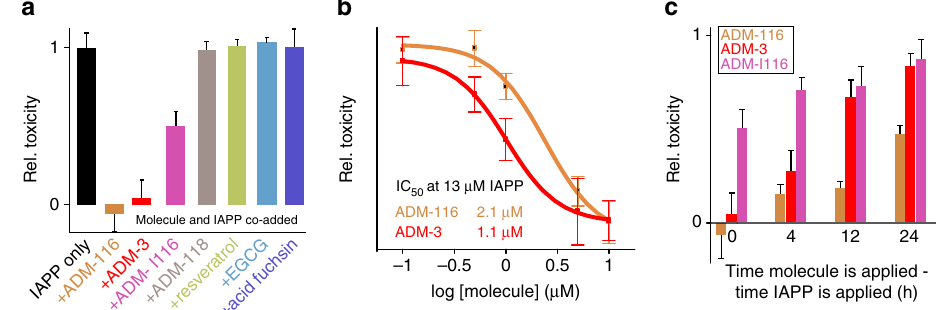
Figure 4 | Rescue of INS-1 cells from IAPP-induced toxicity. ( a ) Statistics of the toxic effect of 13 m M IAPP applied at time zero to INS-1 cells and measured 48h later using CellTiter Blue. Data are shown for IAPP alone and with equimolar ratio of the indicated small molecule co-added at a 1:1 ratio. Data are renormalized to the toxicity induced only by IAPP. Each condition is the average of eight on-plate repeats from each of three independently performed replicates ( n ¼ 24). ( b ) Dose dependence of toxic rescue by ADM-3 and ADM-116. ( c ) Relative toxicity of 13 m M IAPP in which a time delay is introduced between the addition of IAPP and addition of molecule. ( a – c ) Error bars are s.d.’s from three sets of experiments conducted on separate occasions. rel.,